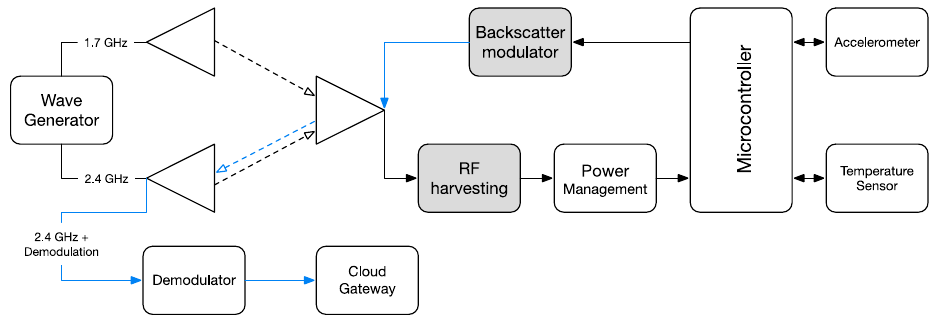
Figure 2. Block diagram of the implemented system.